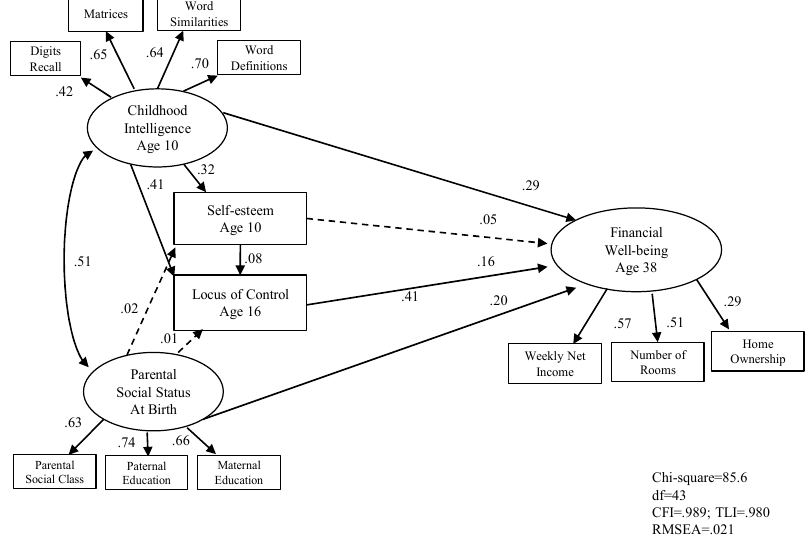
Figure 1. SEM Model 1 early indicators associated with adult financial well-being in male sample ( n = 2275).